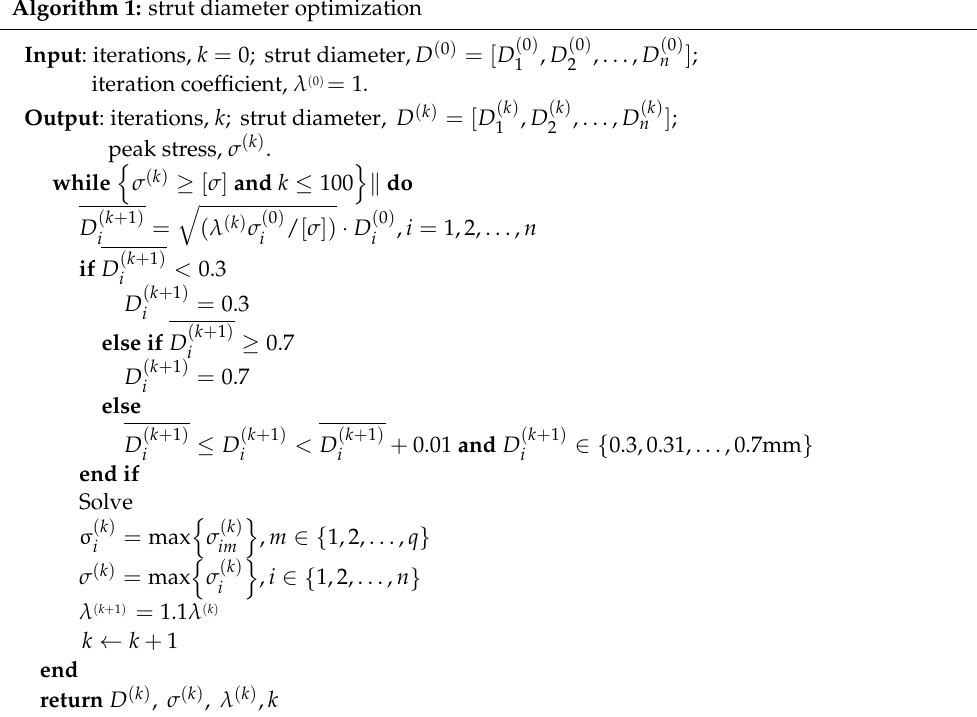
Algorithm 1: strut diameter